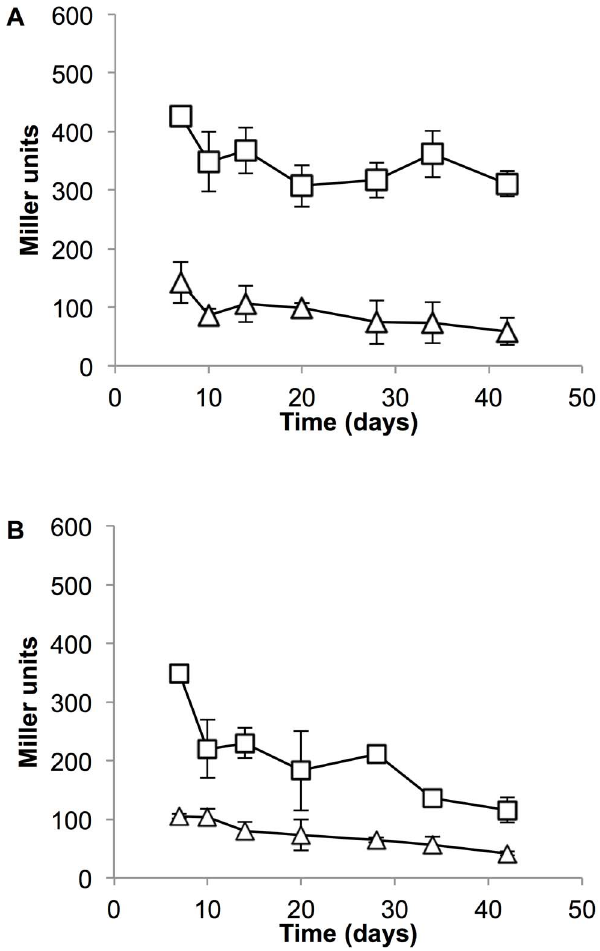
Figure 2. P mbtB and P mbtI activity during hypoxia is DosR- dependent. (A) P mbtB and (B) P mbtI activity was determined in bacteria during oxygen depletion in the Wayne model of hypoxia. Triangle – DosR D strain; square – DosR D complemented strain (C 9 ). Data are the mean and standard deviation from three independent transformations.